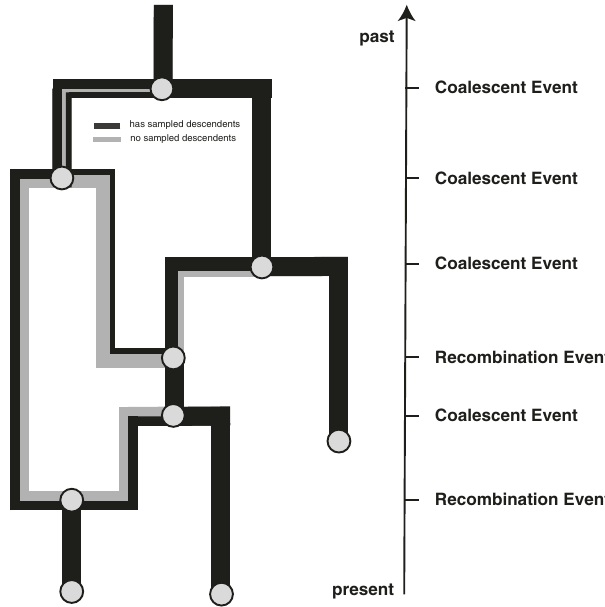
Fig. 4 Example recombination network. Events that can occur on a recombination network as considered here. We consider events to occur from the present backward in time to the past (as is the norm when looking at coalescent processes). Lineages can be added upon sampling events, which occur at prede fi ned points in time and are conditioned on. Recombination events split the path of a lineage in two, with everything on one side of a recombination breakpoint going in one direction and everything on the other side of a breakpoint going in the other two viruses. For NL63, we fi nd weak evidence for the rate on S2 to be slightly higher than on S1 (Fig. 3), even though the rates of adaptation are inferred to be higher on S1. The absolute rate of 229E or OC43. Additionally, the uncertainty around the estimates on adaption rate ratios between the two subunits for NL63 is rather large and includes no difference at all. Overall, these results suggest that particular recombination events that have resulted in